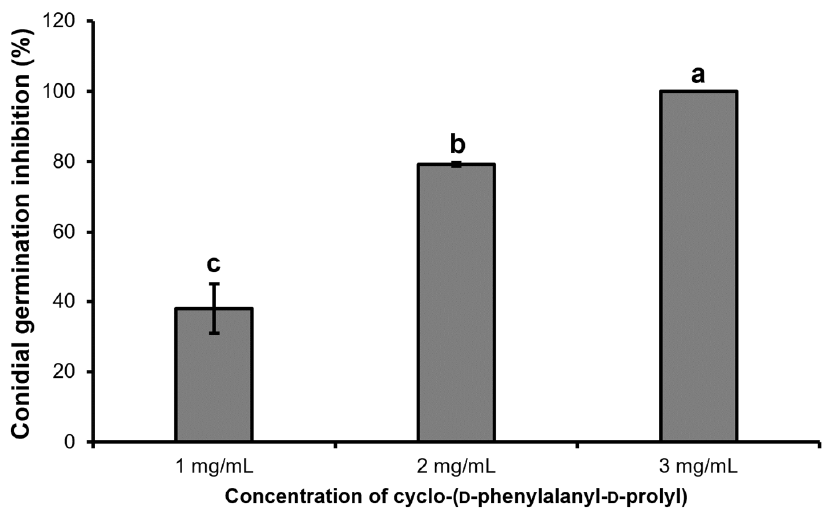
Figure 8. Inhibition of conidial germination of C. gloeosporioides by different concentrations of a purified dipeptide, cyclo-( D -phenylalanyl- D -prolyl). Histograms represent the mean ± standard deviation of three replications. Different letters represent significant differences (LSD test, p < 0.05).